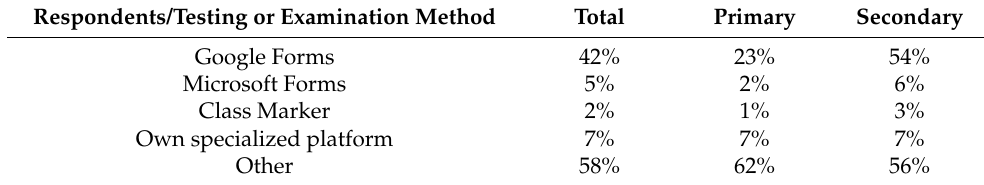
Table 13. Testing or examination method used during the COVID 19 pandemic (question